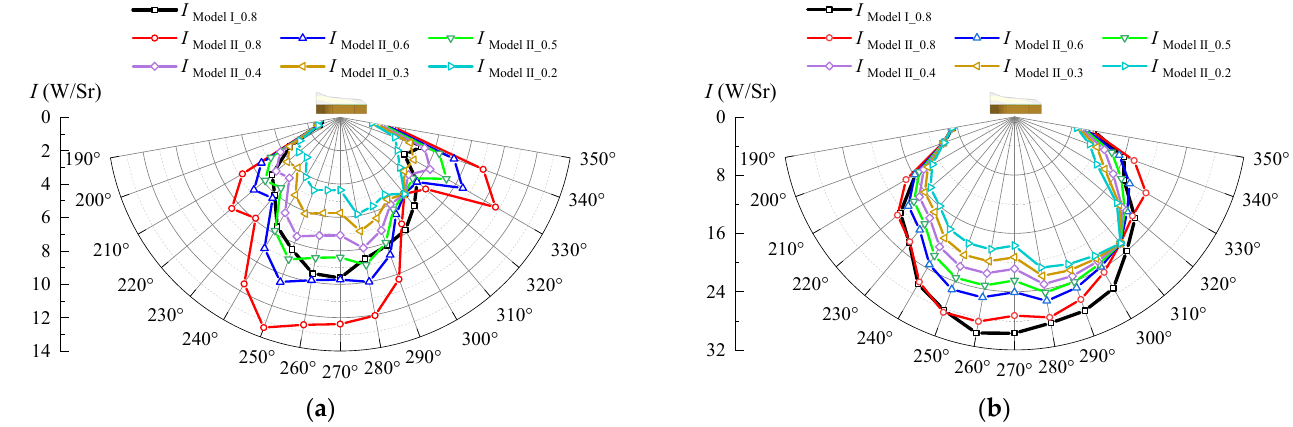
Figure 29. Total infrared radiation intensity of models with different emissivity of deflectors. ( a ) 3–5 µm band; and ( b ) 8–14 µm band.